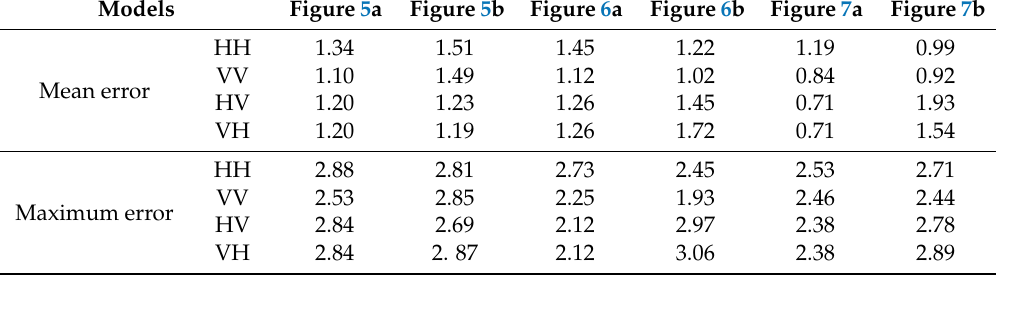
Table 3. Mean errors and maximum errors (unit: dB) between FPFSM and SSA-II. Models